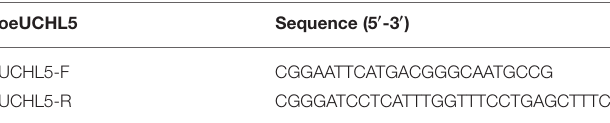
TABLE 2 | Sequences of UCHL5 CDs